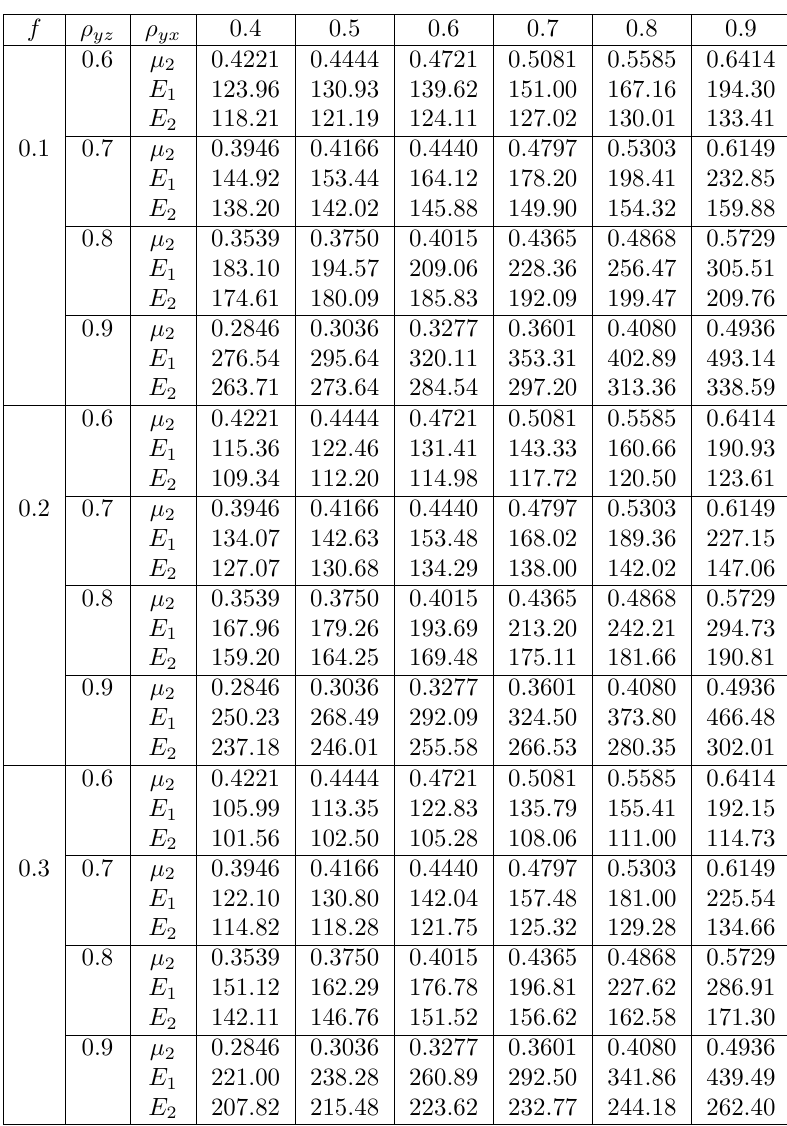
Optimum value of (cid:22) 2 and PREs of T 2 ( d ) with respect to ((cid:22) y n ) and (^(cid:22) Y